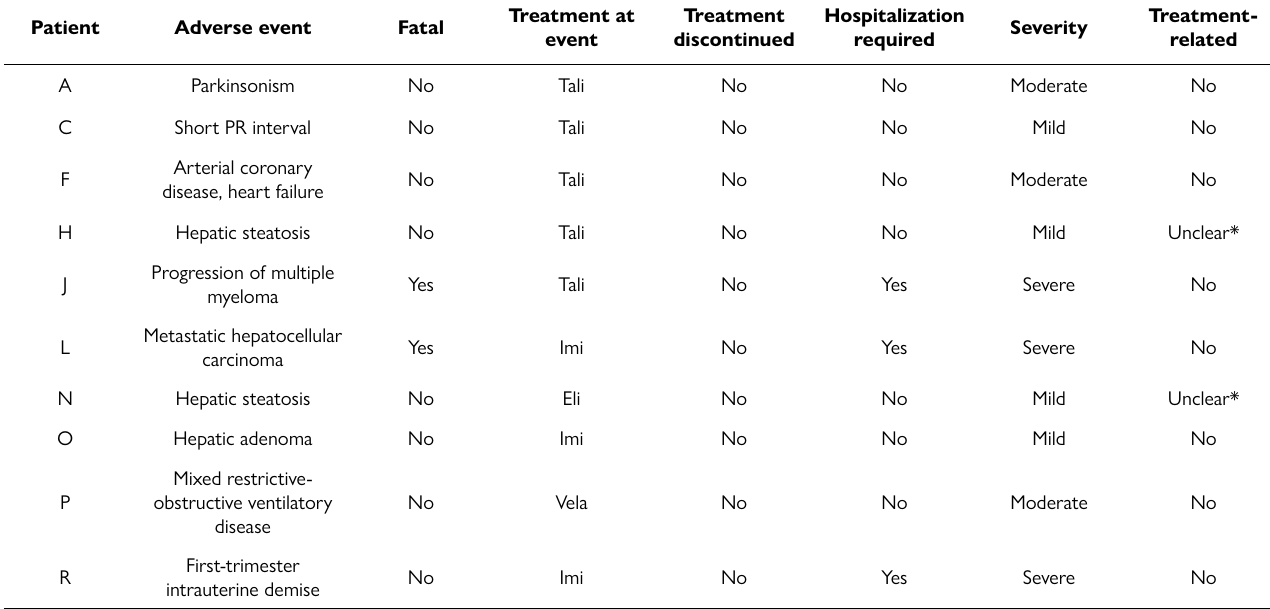
Table 3. Adverse events, severity, and relationship to treatment.